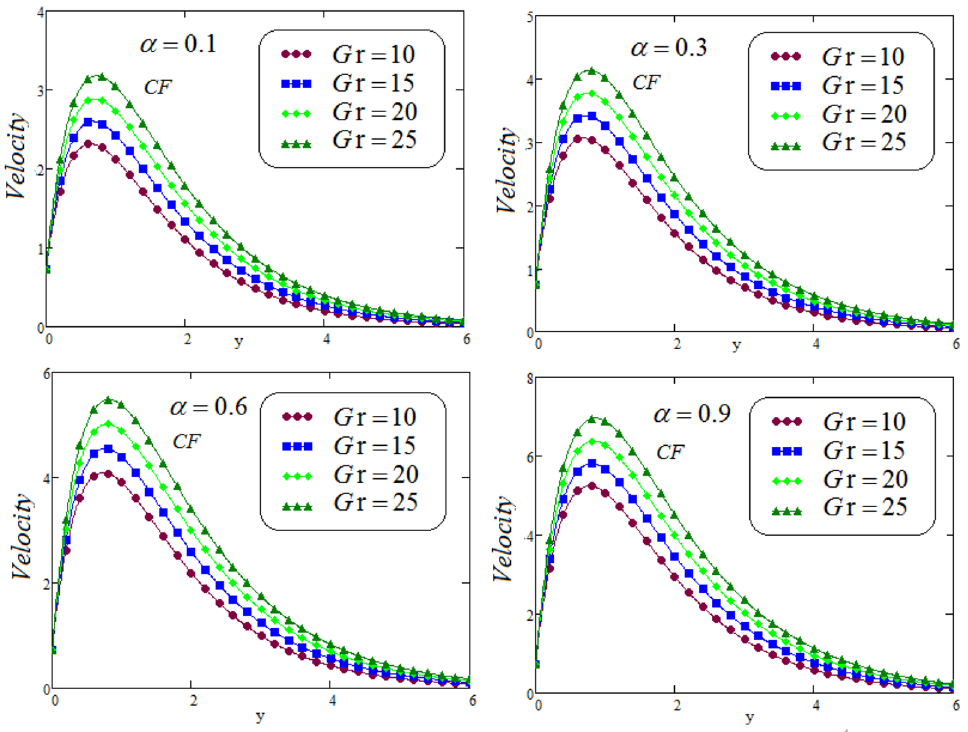
Figure 8. Representation of second grade fluid velocity via CF for distinct values of Gr